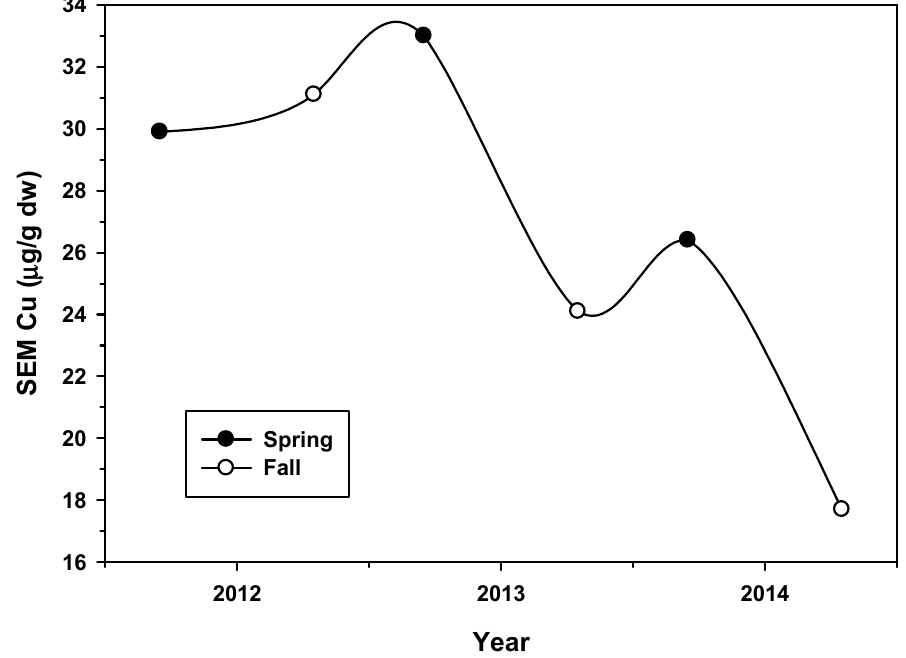
Figure 13. SEM copper concentrations (µg/g dry wt) from spring and fall sediment sampling at Cache Slough site CS-12 for the years 2012, 2013 and 2014.